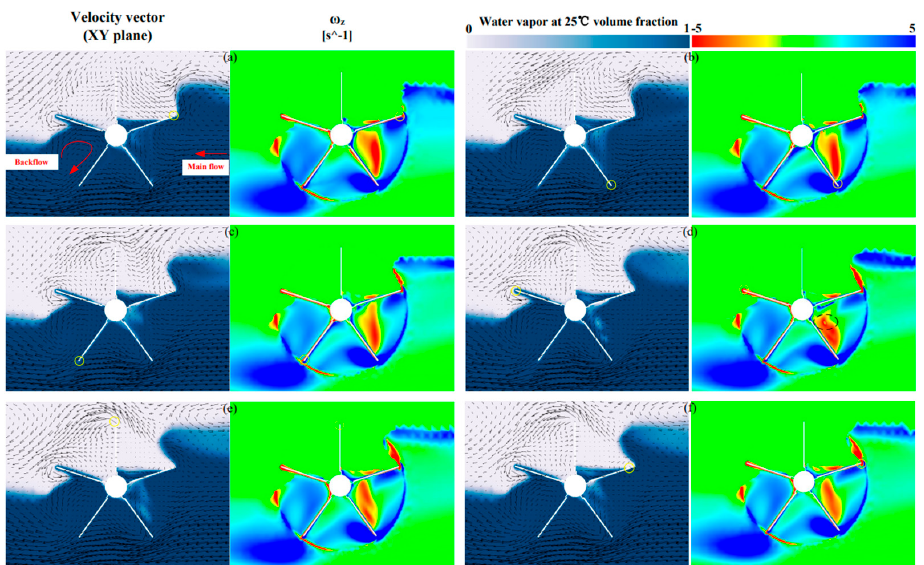
Figure 10. Contours of velocity vectors, water volume fraction, and vorticity in a cycle of the 120 mm clearance water wheel. ( a ) The circumferential angle θ = 0°; ( b ) The circumferential angle θ = 72°; ( c ) The circumferential angle θ = 144°; ( d ) The circumferential angle θ = 216°; ( e ) The circumferential angle θ = 288°; ( f ) The circumferential angle θ = 360°.